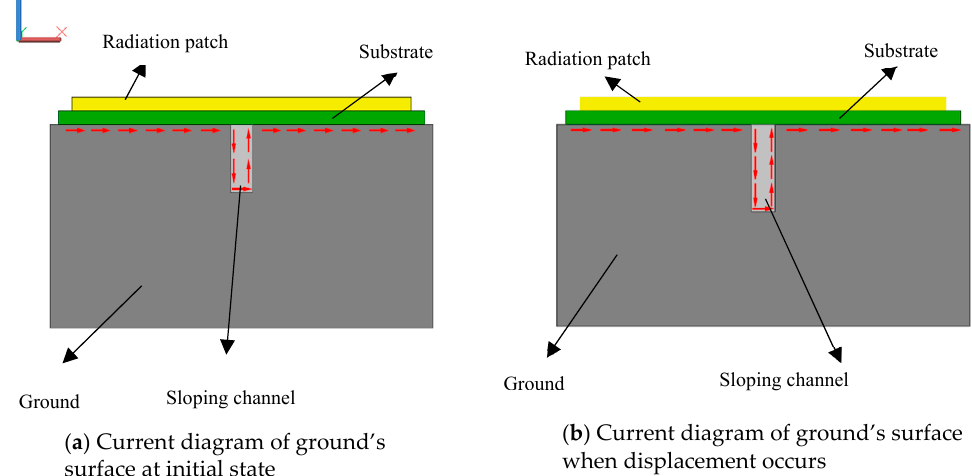
Figure 4. Current diagram of ground’s surface.